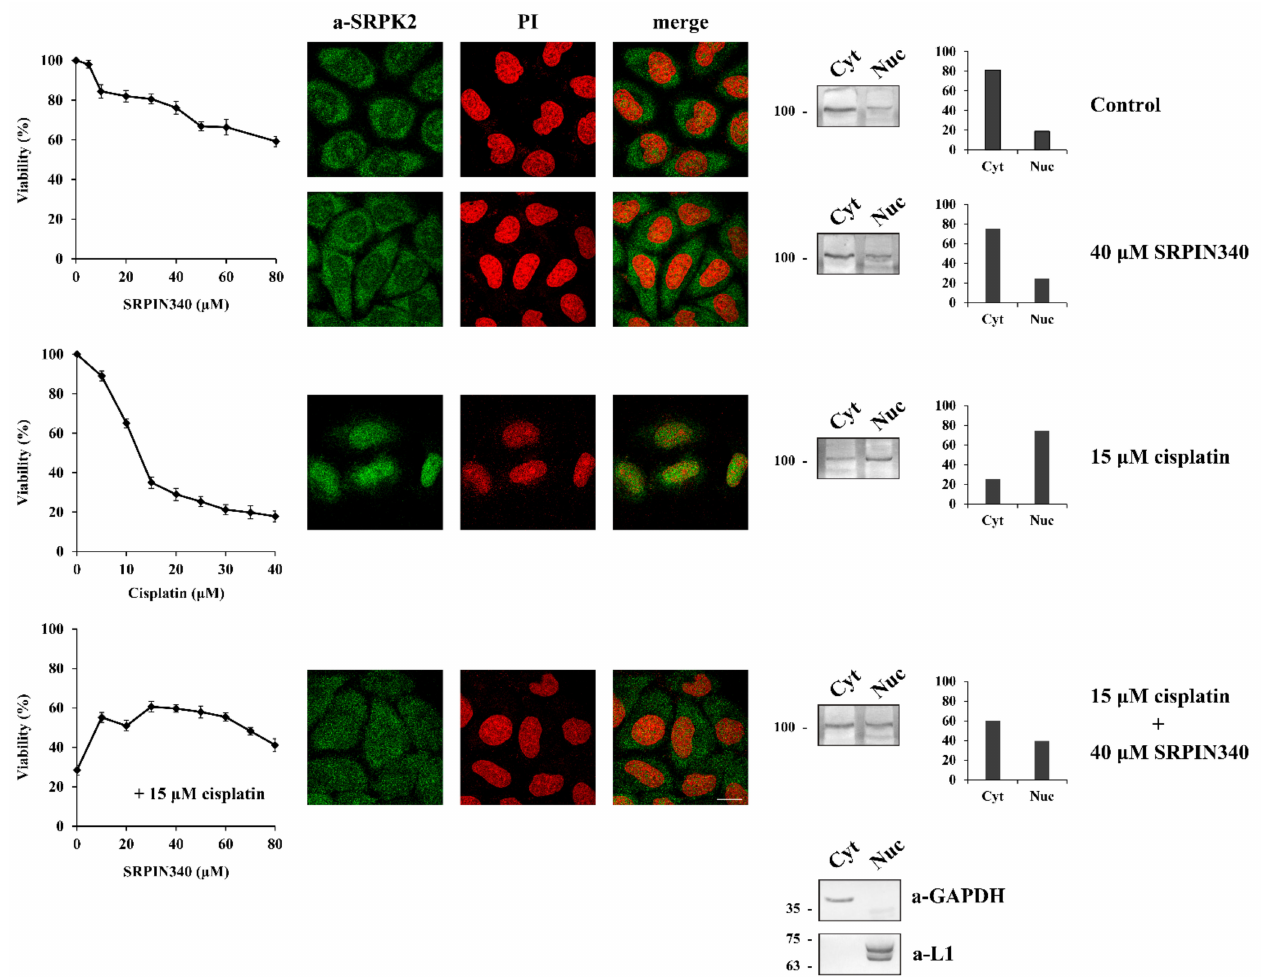
Figure 1. SRPIN340 treatment prevents the nuclear import of SRPK2 in cisplatin-treated HeLa cells and protects the cells from the cytotoxic effects of the drug. HeLa cells were treated with SRPIN340 (5–80 µ M) alone, cisplatin (5–40 µ M) alone, and cisplatin (15 µ M) combined with increasing concentrations of SRPIN340 (10–80 µ M) for 24 h. The number of viable cells was measured with an MTT assay ( left panel ). Viable cells were quantified by normalizing the absorbance readings to the untreated control cells, which was set as 100% viability. Correspondingly, the figure shows fluorescent patterns of SRPK2 in HeLa cells treated for 24 h with SRPIN340 (40 µ M) alone, cisplatin (15 µ M) alone, and cisplatin (15 µ M) combined with SRPIN340 (40 µ M) ( middle panel ). SRPK2 was detected using the anti-SRPK2 monoclonal antibody, while nuclei were stained with propidium iodide (PI). Scale bar: 10 µ m. A cell fractionation procedure was also employed to determine the distribution of SRPK2 ( right panel ). SRPK2 was detected in cytoplasmic (Cyt) and nuclear (Nuc) extracts by Western blotting using the anti-SRPK2 monoclonal antibody. The nuclear-to-cytoplasmic SRPK2 ratios in the Western blots shown were quantified using ImageJ software. Glyceraldehyde-3-phosphate dehydrogenase (a-GAPDH) and lamins (a-L1) were used as cytosolic and nuclear markers,